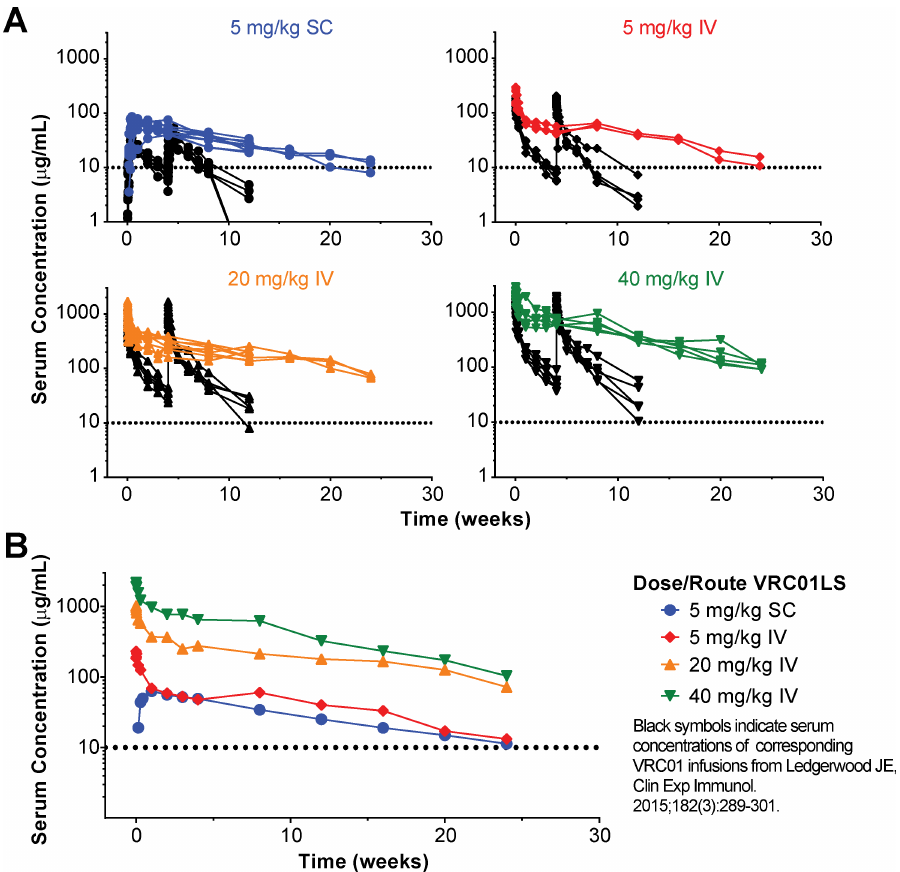
Fig 2. Measurement of antibody serum concentration ( μ g/mL). (A) Serum VRC01LSconcentrations (coloredplots) are shownfrom first measurement through week 24 after a singleadministration. The infusion dose and route are as specifiedin the legend.All values are the mean of duplicatesamplesrun in different wells within the same plate. Previously publishedVRC01 concentrations basedon historical data (black plots) after administration at weeks 0 and 4 are shown for comparison. (B) Geometric mean serum VRC01LS concentrations per group over time. The dotted line at 10 μ g/mL on each graph is shown as a reference value. IV, intravenous; SC,